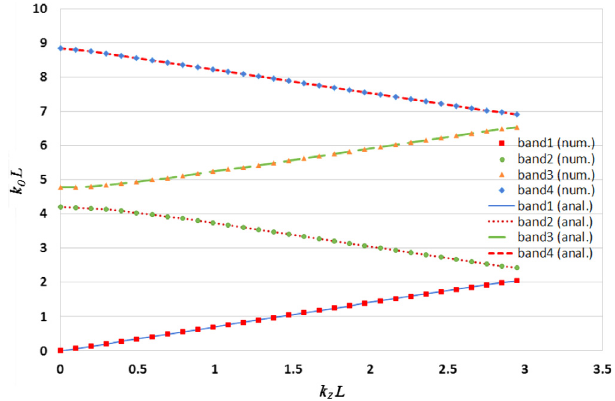
Figure 7. Comparison between band diagrams from analytical and numerical calculation for a 9th order fractal MTM.